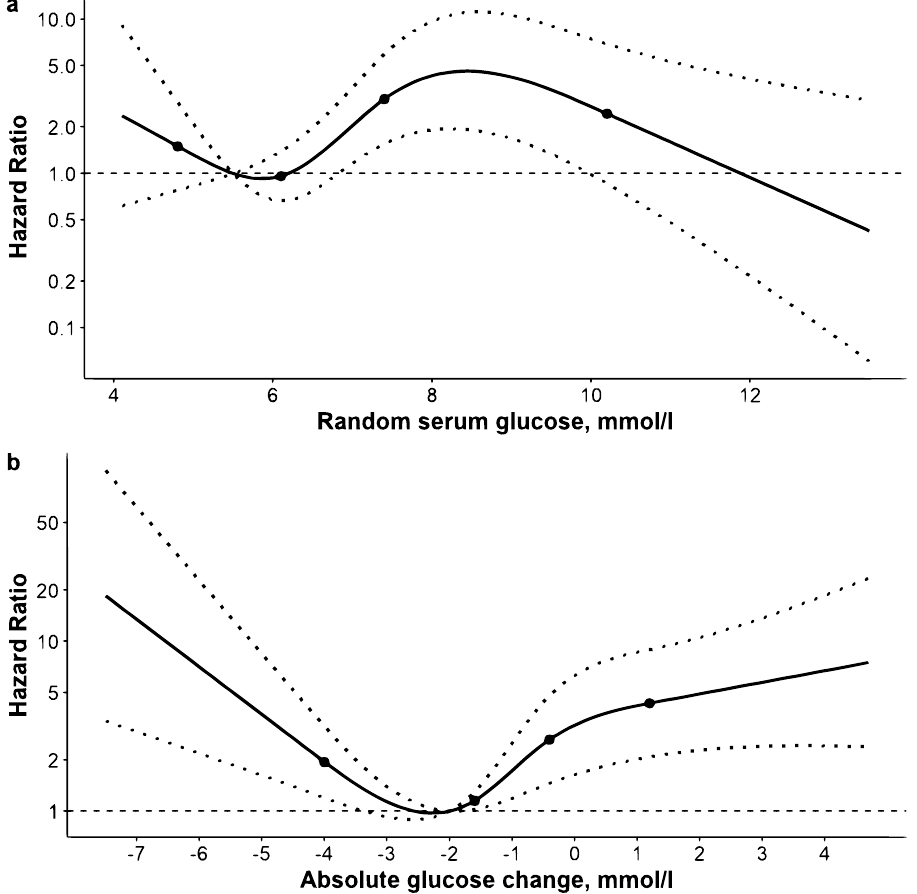
Figure 1. Association of admission random serum glucose and glycemic change with 30-day mortality after lobar intracerebral hemorrhage. Panel ( a ) refers to random serum glucose (RSG) on admission and Panel ( b ) to glycemic change within the following 48 h in 245 non-diabetic patients. Hazard ratios (solid line) and 95% confidence intervals (dotted lines) are from a Cox regression model using restricted cubic splines with four knots (represented by dots) located at the 5th, 35th, 65th, and 95th percentiles of each glucose measure. Reference value is set at 5.5 mol/l for RSG and at the minimum mortality point for glycemic change. Models were adjusted for age, sex, prestroke disability, heart disease, anticoagulant use, Glasgow Coma Scale, hematoma volume and prevalence of intraventricular hemorrhage. To convert mmol/l to mg/dl, multiply by